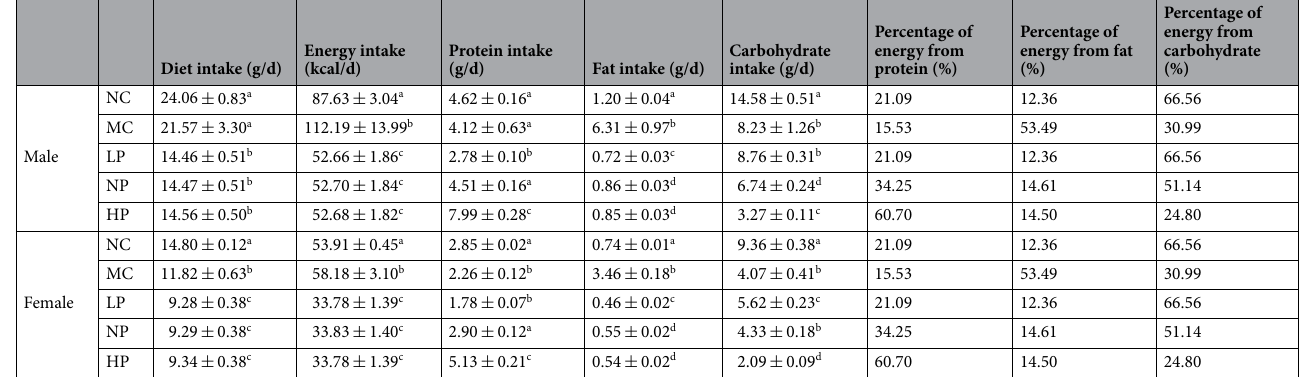
Table 4. Intakes of diets, energy, macronutrients and the percentage of energy from macronutrients of rats in different groups. NC normal control group, MC model control group, LP low energy low protein group, NP low energy normal protein group, HP low energy high protein group. Values are the mean ± SD. Mean values of the same sex within a column with different superscript letters (a, b, c, d) were significantly different ( P <